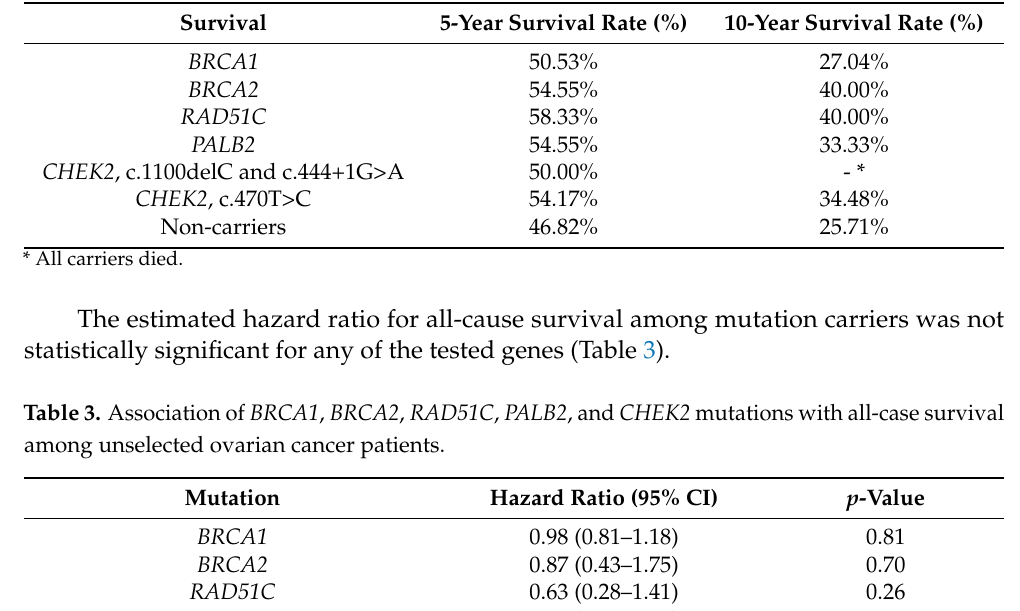
Table 2. The 5- and 10-year survival of ovarian cancer patients by mutation status.